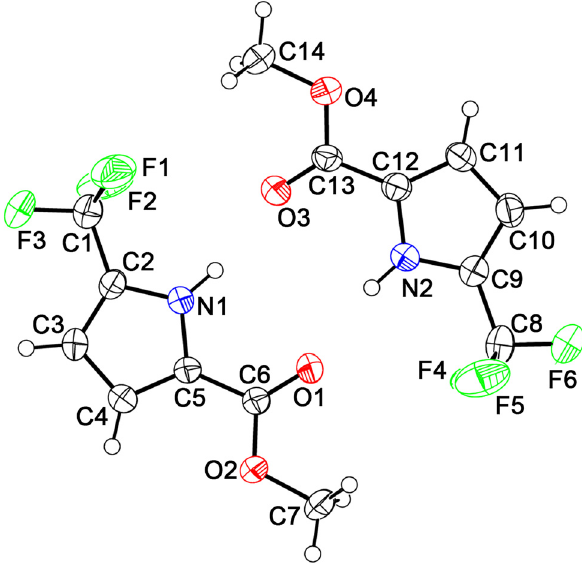
Table 1 contains crystallographic data and Table 2 contains the list of the atoms including atomic coordinates and displacement parameters.